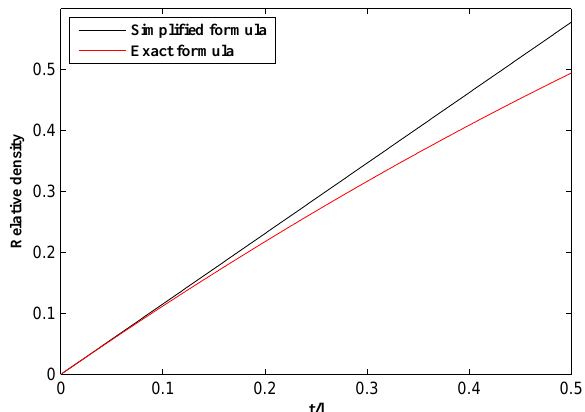
Figure 4. Comparison of relative density values based on simplified or exact formulas for regular hexagonal honeycombs.